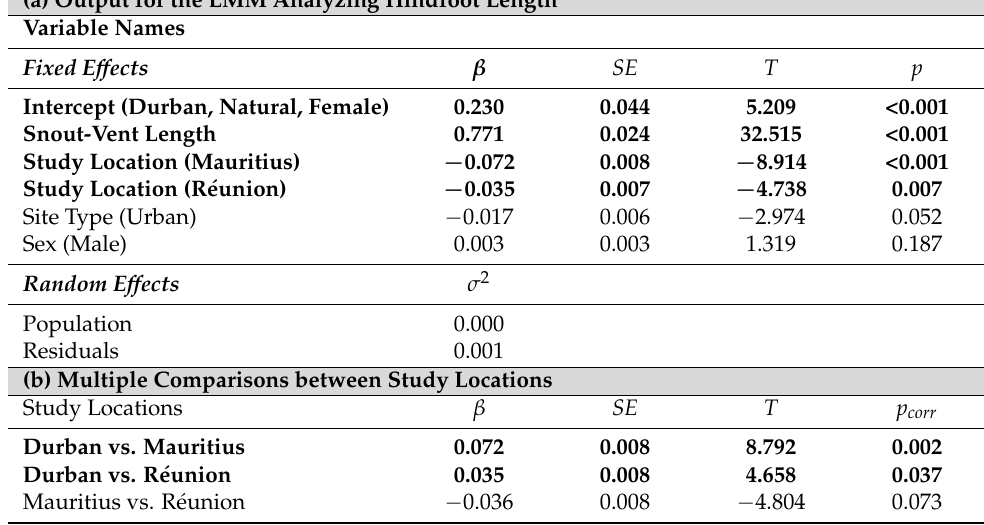
Table 5. ( a ) Outcome of the LMM examining differences in guttural toad ( Sclerophrys gutturalis ) hindfoot length (mm). All coefficient estimates are representative of log 10 -transformed morphological measures. Since the interaction between study location and site type was not significant, it was removed and the models were re-run. Coefficient estimates ( β ) of fixed effects are presented with their corresponding standard errors ( SE ), variance estimates ( σ 2 ) are supplied for residuals and random effects, and all significant values ( p < 0.05) are bolded. Reference levels for each categorical variable are supplied in brackets following the variable name. ( b ) Post hoc multiple comparisons of hindfoot length between all study locations; in this case, p -values ( p corr ) were corrected using an “ mvt ” adjustment